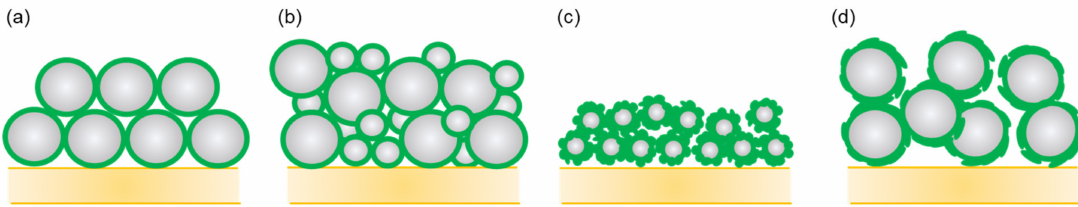
Figure 4. Cross-sectional illustration of core–shell-type PANI-sphere-deposited film: ( a ) close-packed structure consisting of uniform sized spheres, ( b ) structure consisting of irregularly sized spheres, ( c ) actual structure consisting of uniform nanometer-sized spheres, and ( d ) actual structure consisting of uniform micrometer-sized spheres.